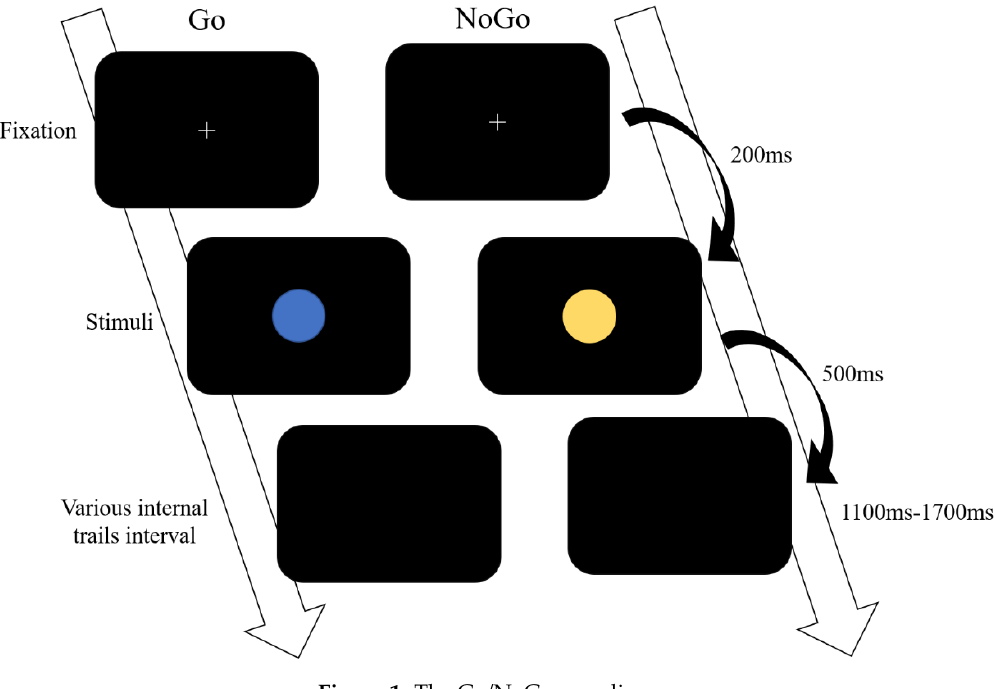
Figure 1. The Go/NoGo paradigm. Figure 1. The Go / NoGo